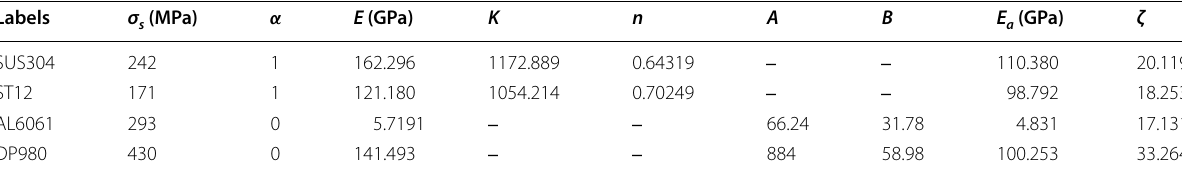
Table 2 Nominal identified material properties for different